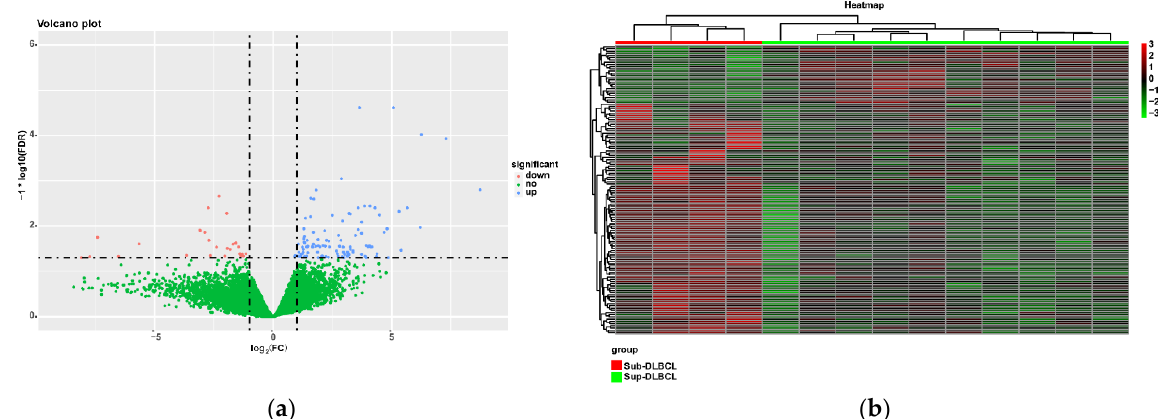
Figure 4. Differentially expressed genes (DEGs) between the supradiaphragm group and subdiaphragm group: ( a ) Volcano plot of DEGs; ( b ) heat map of DEGs. Differential-expressed genes are represented in rows, and samples are represented in columns. The expression value for each row was normalized by the z-score. Red stripes indicate high expression and green stripes indicate low expression of genes. Green bar represents Sup-DLBCL samples, while red represents Sub-DLBCL samples.